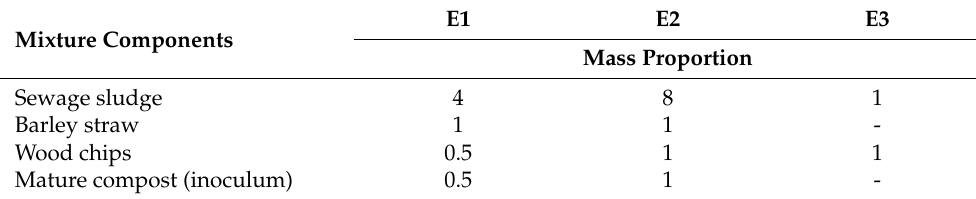
Table 2. The composition of the mixture to be composted. Mixture